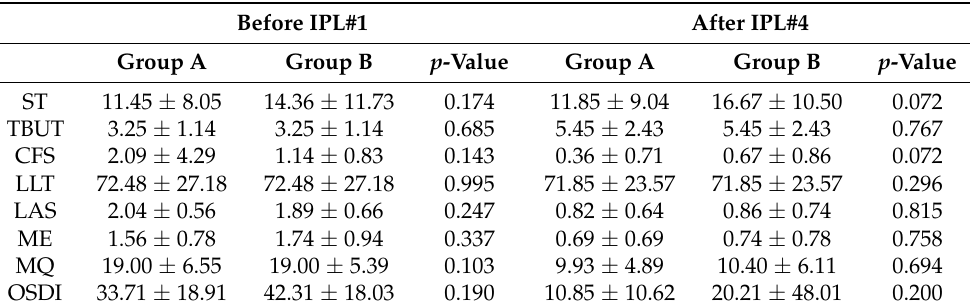
Table 3. Comparison of DE and MGD parameters and OSDI obtained before IPL#1 and after IPL#4 in Groups A and B.